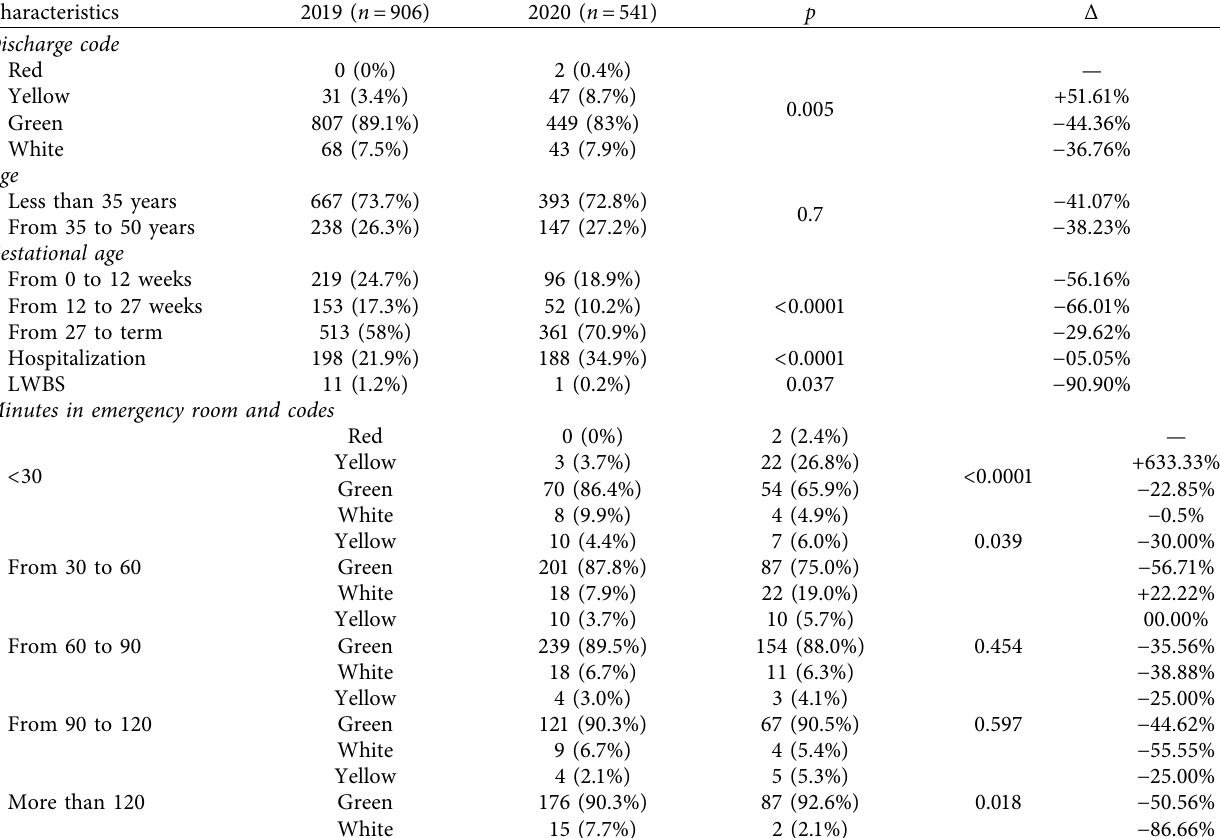
Table 4: Obstetrical patients’